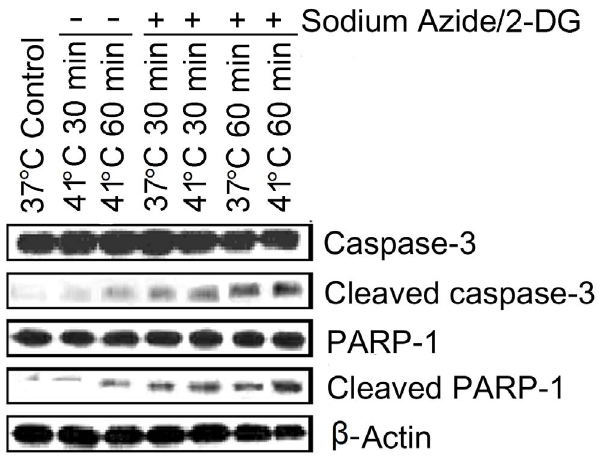
Figure 6. Caspase-3 was activated following the treatments. Cells were subjected to treatments with sodium azide/2-DG, increased temperature or combination of sodium azide/2-DG plus increased temperature for a period of 30 minute or 1 hour. Control cells received no treatment. Cleavage of caspase-3 and PARP-1 were analyzed with western blot. b -actin was used as a loading control.